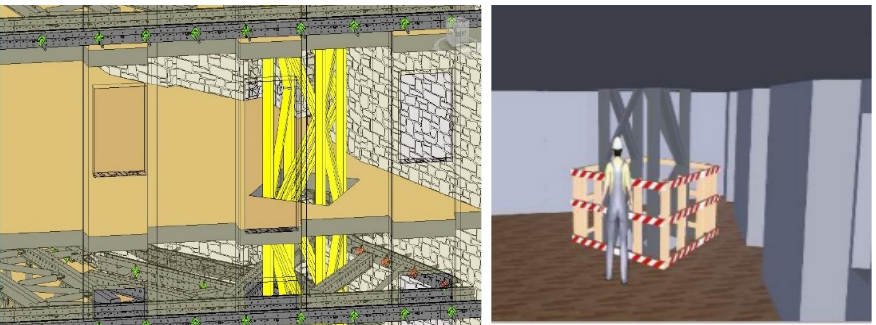
Figure 14. Insertion of the tower crane and guardrails for fall protection in temporary shafts.